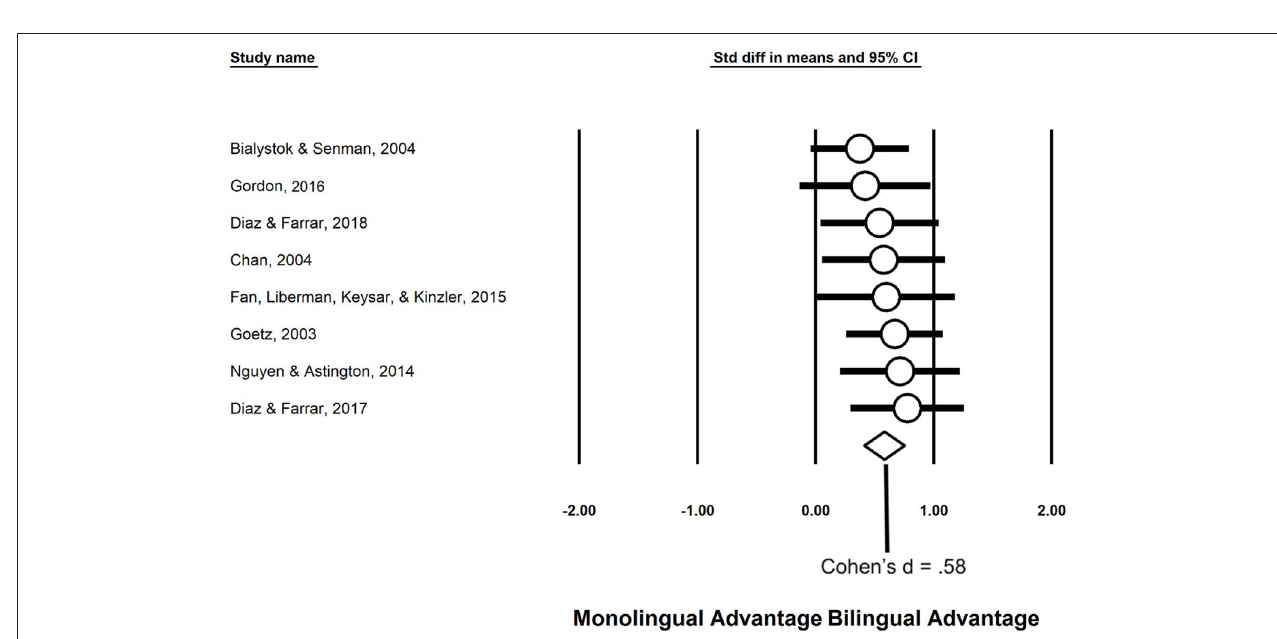
FIGURE 3 | A plot of effect sizes for each of the 8 studies in the secondary analysis, with the summary effect size of .58 at the bottom.